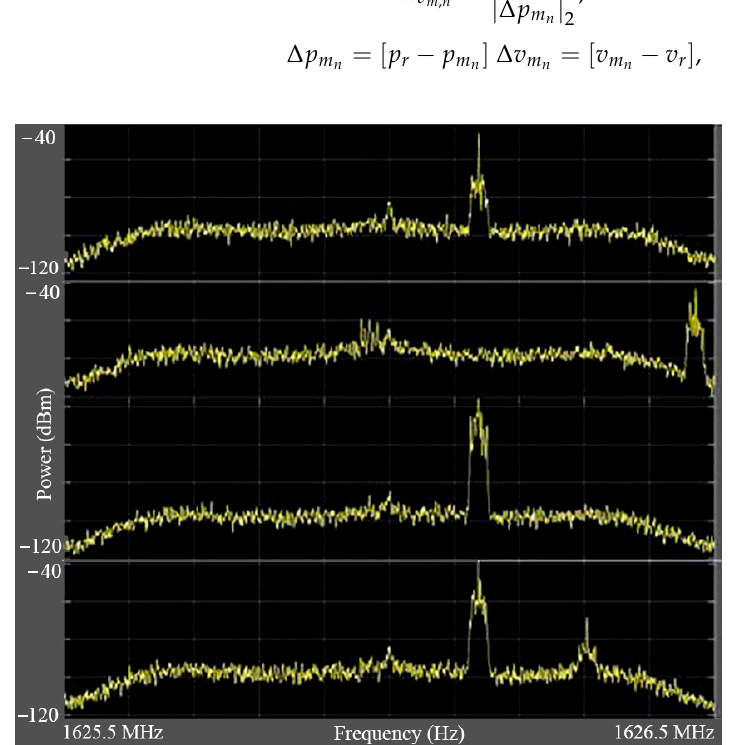
Figure 2. PSD analysis of the Iridium-Next bursts in different time